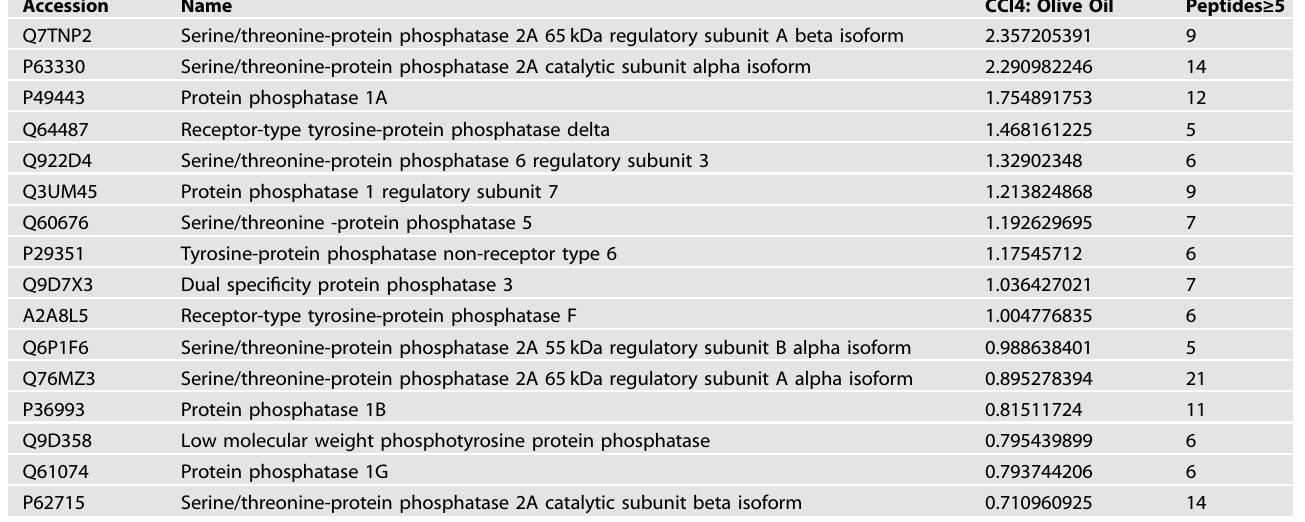
Table 1. Protein phosphatases detected by LC-MS/MS in livers of CCl 4 -induced ALI